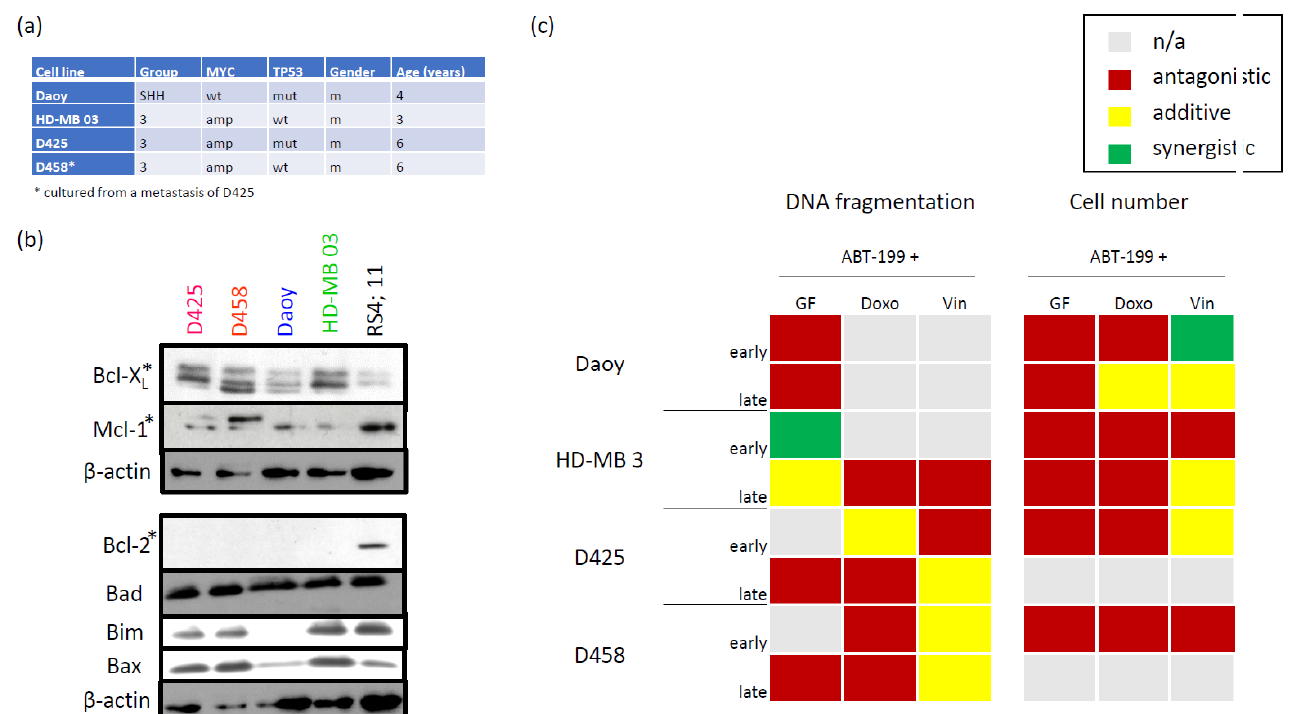
Figure 1. Bcl-XL, but not Bcl-2, is a promising potential therapeutic target in medulloblastoma (MB) cell lines. ( a ) Summary of cell line characteristics. Abbreviations: SHH, sonic hedgehog; wt, wild type; amp, amplified; mut, mutant; m, male. ( b ) Immunoblotting of Bcl-2 family protein expression in MB cell lines. Extracts of four different MB cell lines were subjected to immunoblotting for Bcl-2 family proteins. β -actin served as loading control and the leukaemia cell line RS4;11 served as positive control for Bcl-2 and Mcl-1 expression. Anti-apoptotic members of the Bcl-2 family are marked by an asterisk. ( c ) The inhibitor of Bcl-2, ABT-199, does not show a therapeutic effect on MB cell lines. Cells were stimulated with 10 nM ABT-199 in the presence of either reduced serum concentrations (to 1.5% FCS for Daoy cells or 5% FCS for all others), or the chemotherapeutic drug doxorubicin (5 nM for Daoy cells or 10 nM for all others), or vincristine (1 nM for Daoy cells or 0.5 nM for all others) for either 24 (early) or 96 (late) h, as described in the Materials and Methods section. Left: Cell death was assessed by the surrogate readout of DNA fragmentation, evaluated via flow cytometric analysis of PI-stained nuclei. Right: The number of live cells was counted using the CASY1 DT cell counter. Using Bliss analysis, synergistic (green), additive (yellow) or antagonistic (red) effects were determined, while grey indicates that Bliss analysis was mathematically not possible to perform. Shown in ( b ) is a representative example of two independent experiments, while ( c ) summarizes at least three independent experiments performed in